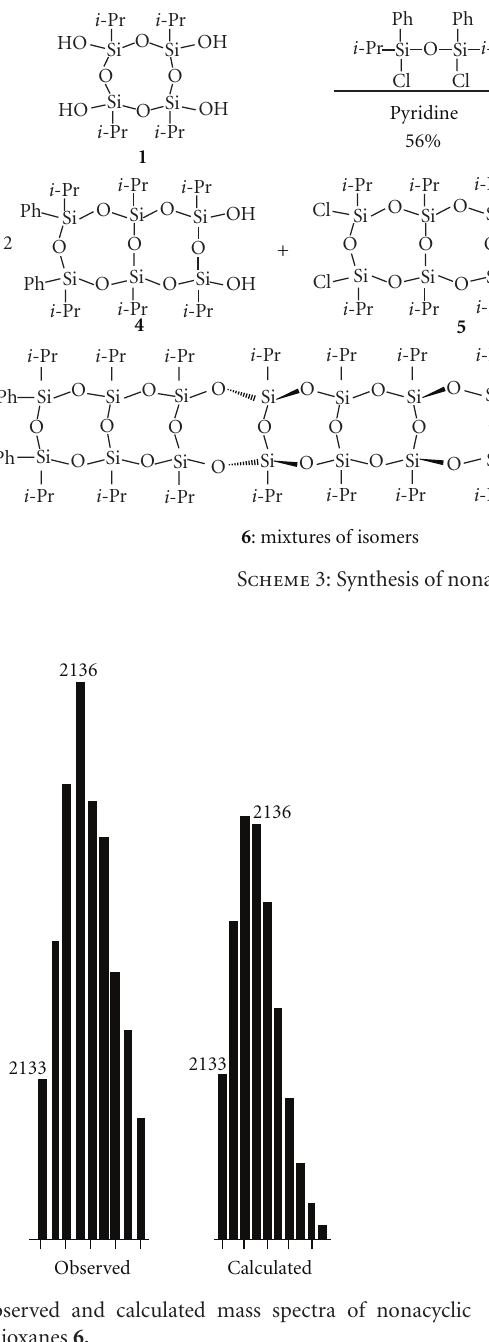
Figure 1: Observed and calculated mass spectra of nonacyclic ladder silsesquioxanes 6.